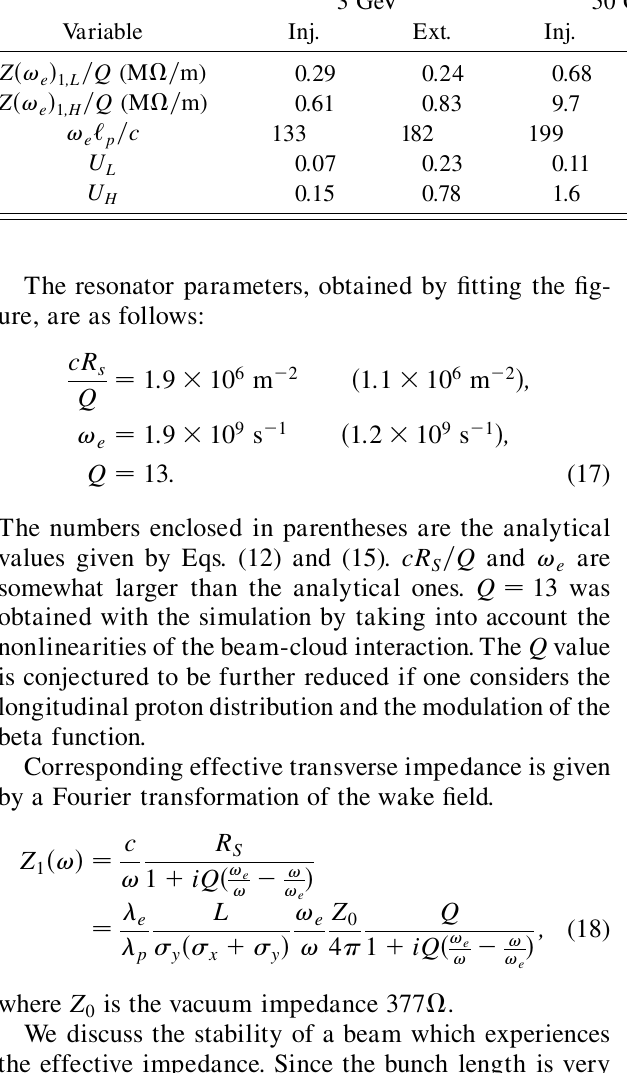
TABLE III. Wake field and stability for electron cloud instability.